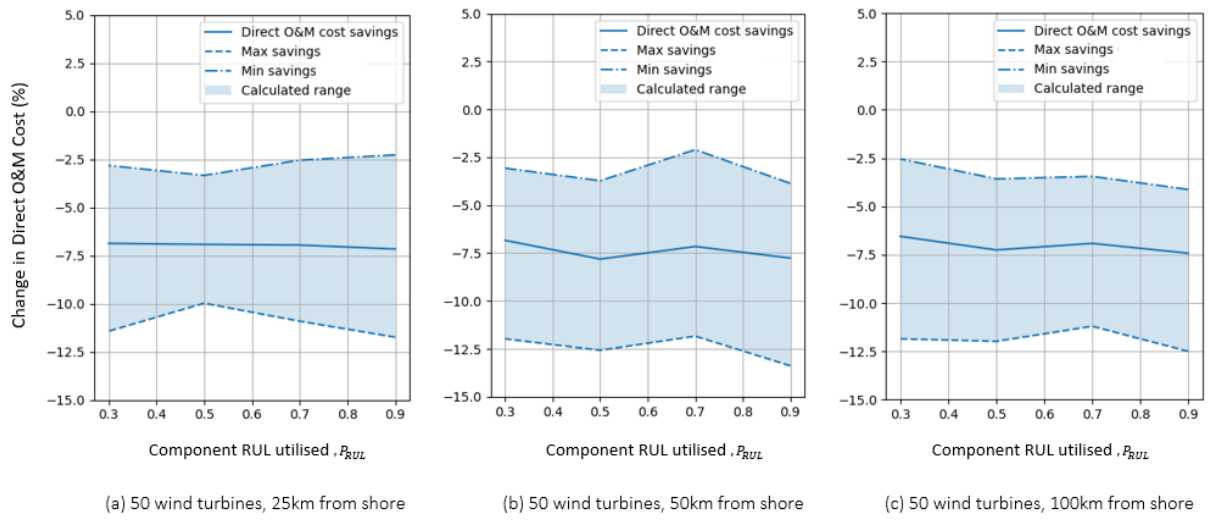
Figure 6. Percentage change in direct O&M costs for predictive maintenance strategies. Subfigures ( a – c ) present results for scenario 2 (50 WT, 25 km from shore), 3 (50 WT, 50 km from shore) and 4 (50 WT, 100 km from shore)